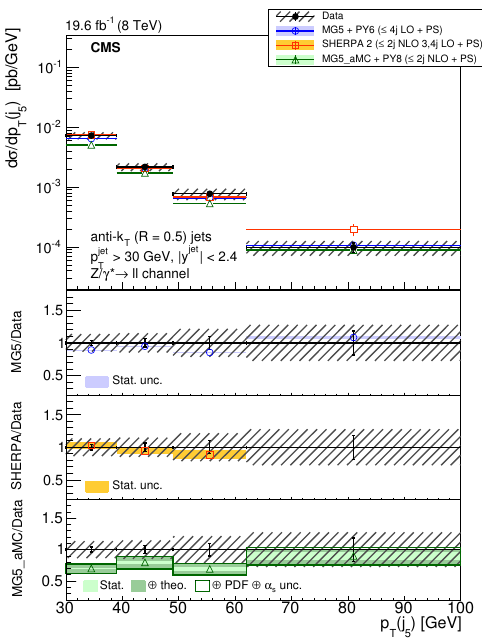
Figure 5 . The di(cid:11)erential cross section for Z ( ! ‘‘ ) + jets production measured as a function of the 5 th jet p T compared to the predictions calculated with MadGraph 5 + pythia 6, sherpa 2, and mg5 a mc + pythia 8. The lower panels show the ratios of the theoretical predictions to the measurements. Error bars around the experimental points show the statistical uncertainty, while the cross-hatched bands indicate the statistical and systematic uncertainties added in quadrature. The boxes around the mg5 a mc + pythia 8 to measurement ratio represent the uncertainty on the prediction, including statistical, theoretical (from scale variations), and PDF uncertainties. The dark green area represents the statistical and theoretical uncertainties only, while the light green area represents the statistical uncertainty